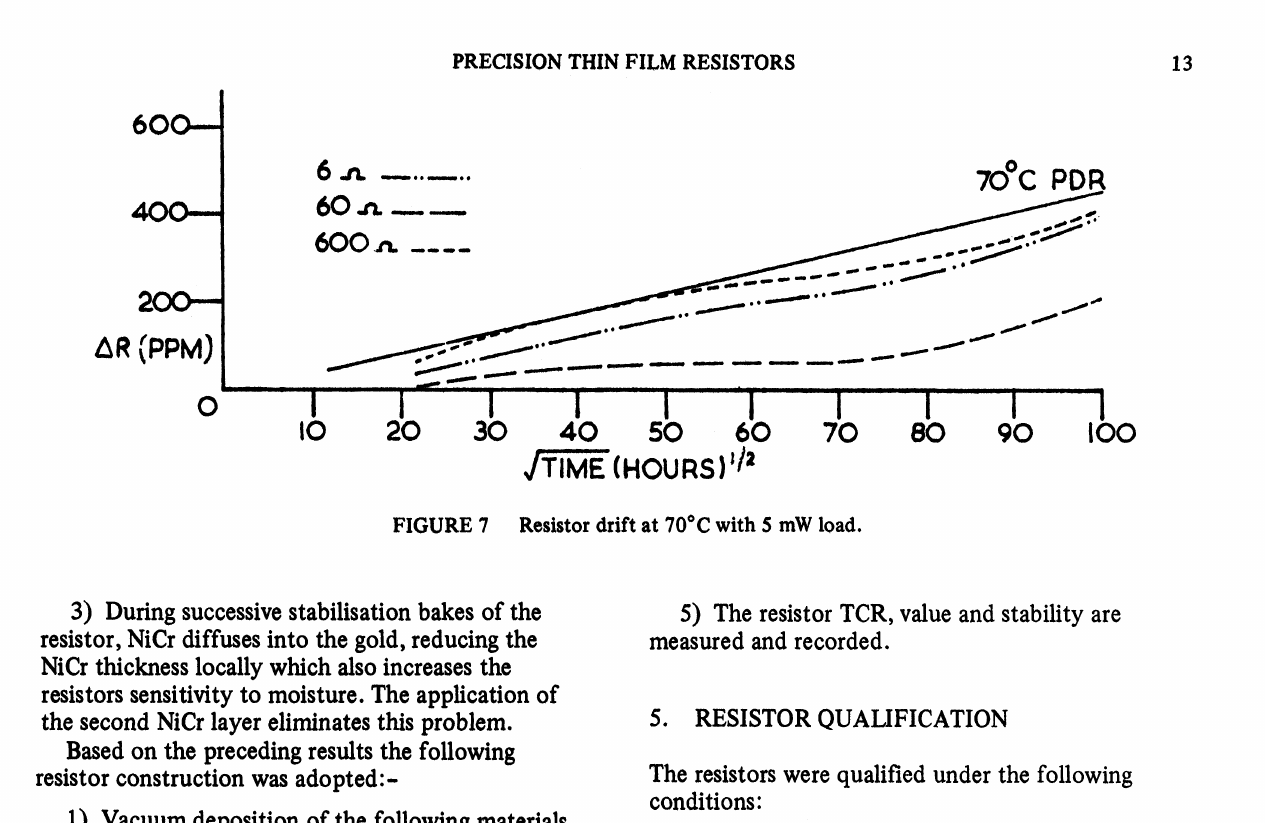
FIGURE 7 Resistor drift at 70C with 5 mW